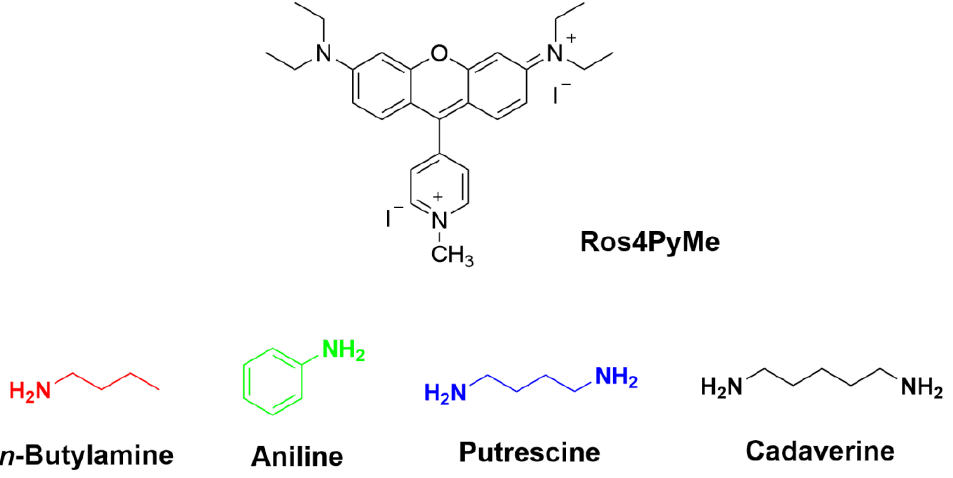
Figure 1. Chemical structures of N -methylpyridinium rosamine (Ros4PyMe, top ) and the selected amines for the sensing studies ( bottom ) — n -butylamine, aniline, putrescine and cadaverine. amines for the sensing studies ( bottom )— n -butylamine, aniline, putrescine and